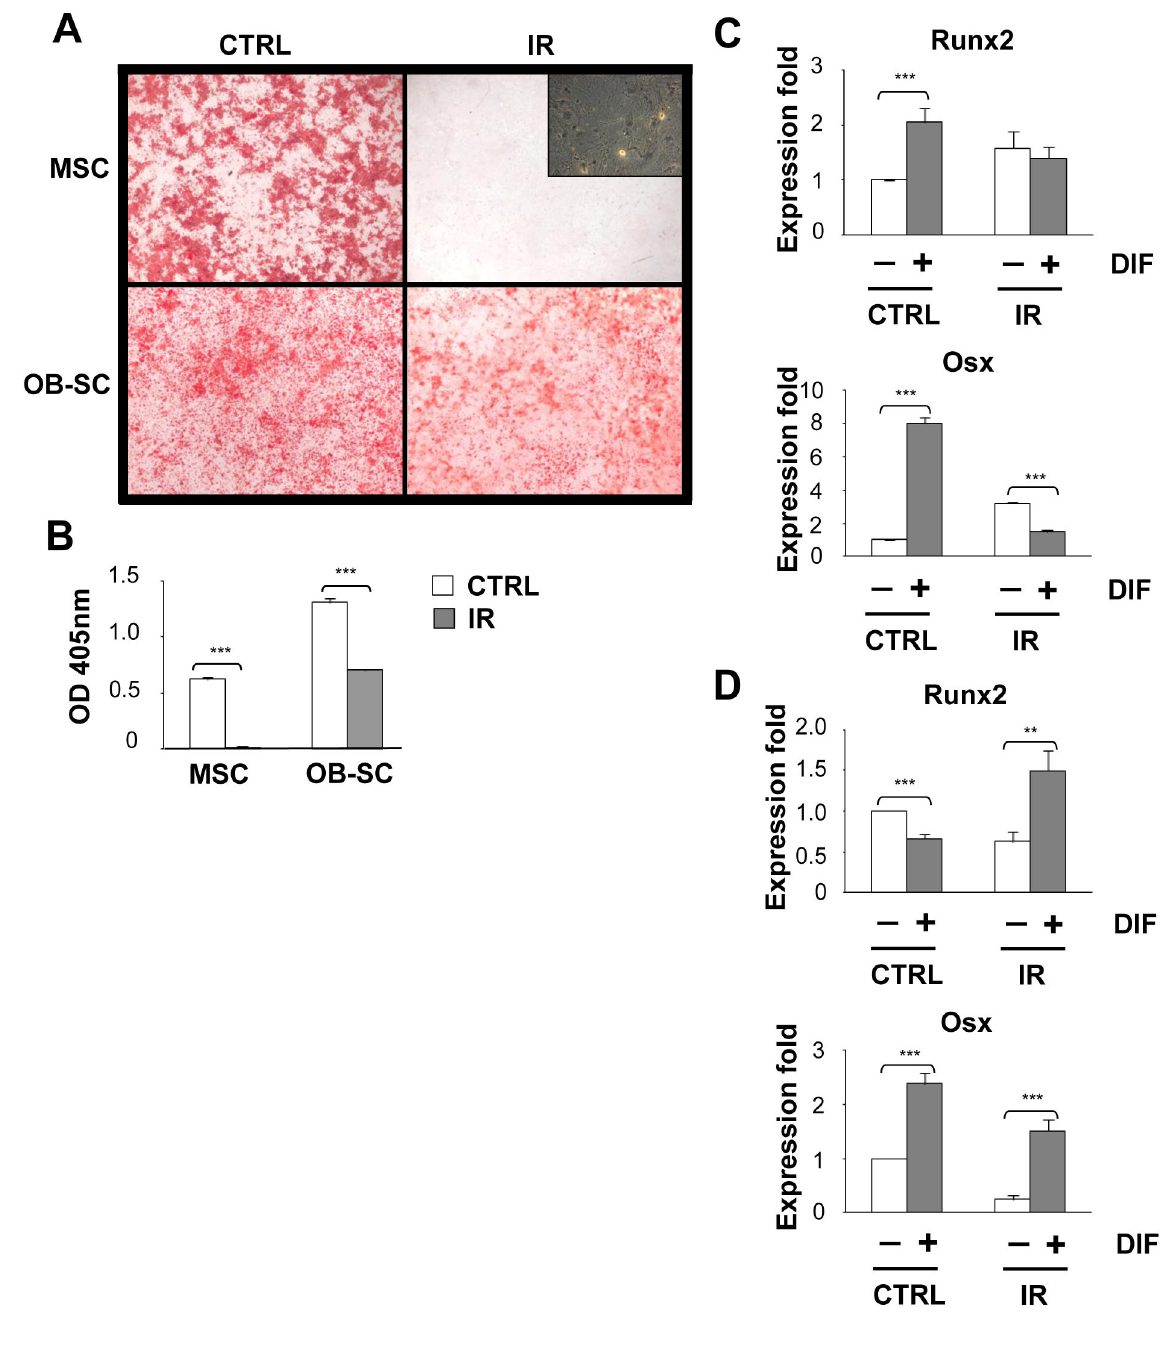
Figure 3. Abrogation of osteogenic differentiation potential following irradiation is limited to stromal progenitor cells. ( A ) MSC and osteoblasts (OB–SC) were exposed (IR) or not (CTRL) to 10 Gy IR and one week later placed in osteogenic differentiation media for 14 to 21 days. Representative photographs showing mineralization nodules accumulation stained with Alizarin Red S is shown for each population. Scale bar: 2mm. Phase contrast photograph showing the presence of senescent MSC in absence of mineralization is also shown. ( B ) Quantification of mineralization was determined by the extraction of Alizarin Red S and detection by spectrophotometry. ( C and D ) Expression of Runx2 and Osx was determined by quantitative real-time PCR using RNA extracted from control and IR-induced senescent MSC and OB–SC populations cultured or not in osteogenic differentiation media. Mean ± standard error; *: p value < 0.05.